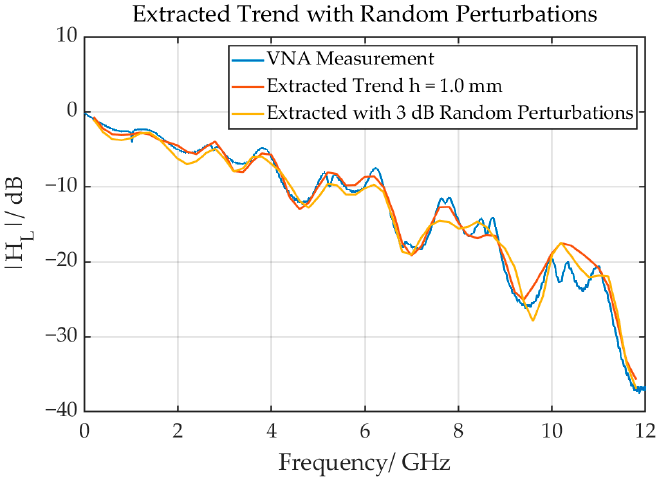
H f . H f . H f . T T T